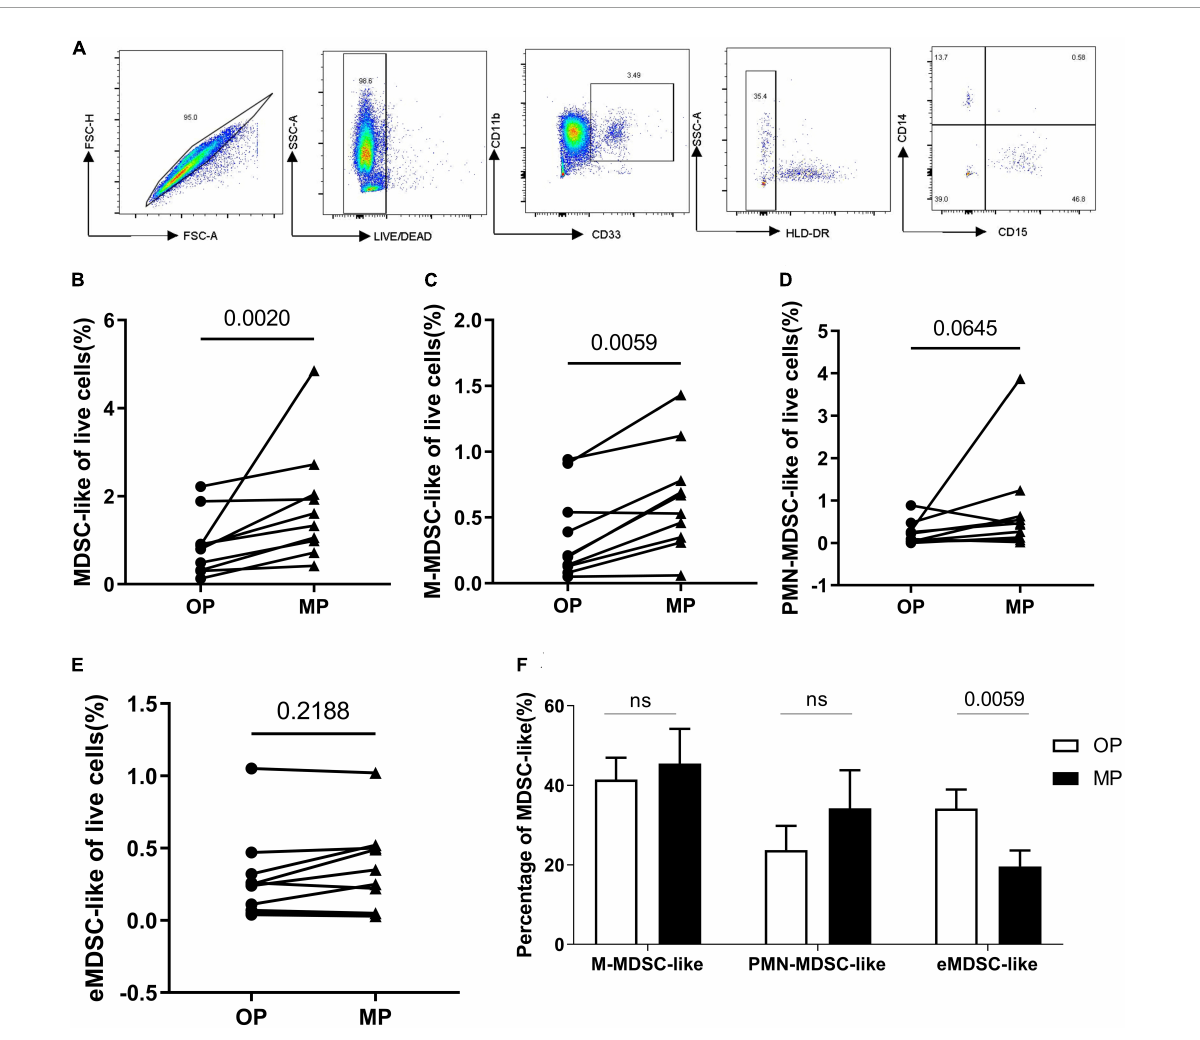
FIGURE2 The change of myeloid-derived suppressor-like cells (MDSC-like), granulocytic-MDSC-like (PMN-MDSC-like), monocytic-MDSC-like (M-MDSC-like) and early-stage-MDSC-like (eMDSC-like). (A) The gating strategy for MDSC-, PMN- MDSC-, M- MDSC-, and eMDSC-like cells. (B) Percentage of live MDSC-like cells increased in the menstrual period (MP) group when compared with the ovulation period (OP) group. (C) Percentage of live M-MDSC-like cells increased in MP samples when compared with OP samples. Scatter diagram showing the percentage of (D) PMN- and (E) eMDSC-like cells within the live cell totals. (F) Bar chart showing the percentage of the total MDSC-like cells presenting as M-, PMN- and eMDSC-like cells. N = 10. Significance determined by paired t -test p < 0.05. The • represents OP and the (cid:78) represents